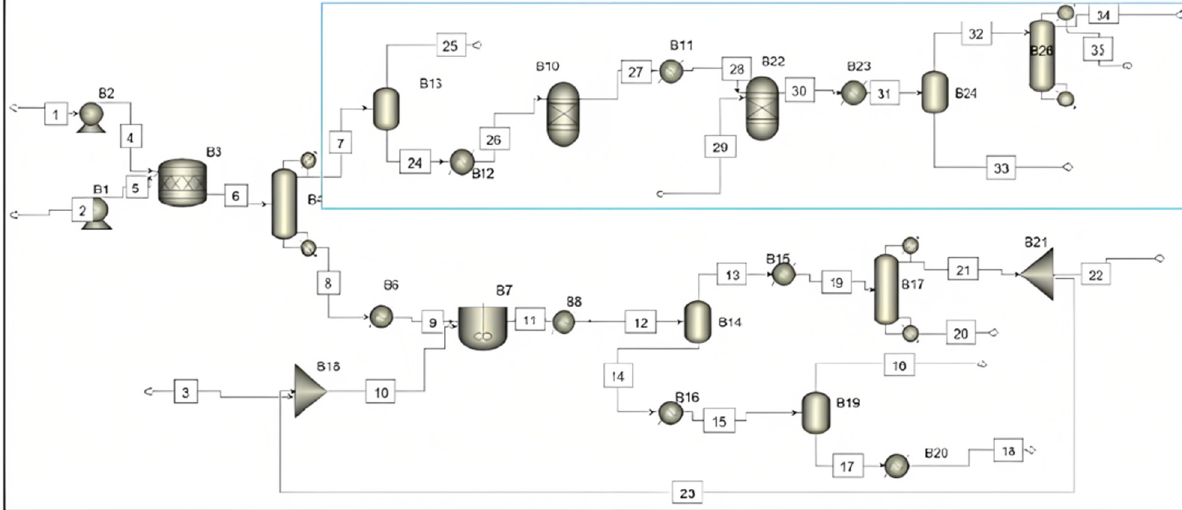
Figure 3. Flow process diagram of the Integrated Process. Stream number 7 is the crude glycerol stream from which water becomes separated in flash drum B13. The bottom product is sent into the pyrolysis reactor B10, then it is sent into the steam fanning reactor, B22. After the liquid components of the resulting streams are knocked out in flash drum B24, pressure swing adsorption is carried out in equipment ID B26, and the 90% pure hydrogen stream number 34 is the final product of the